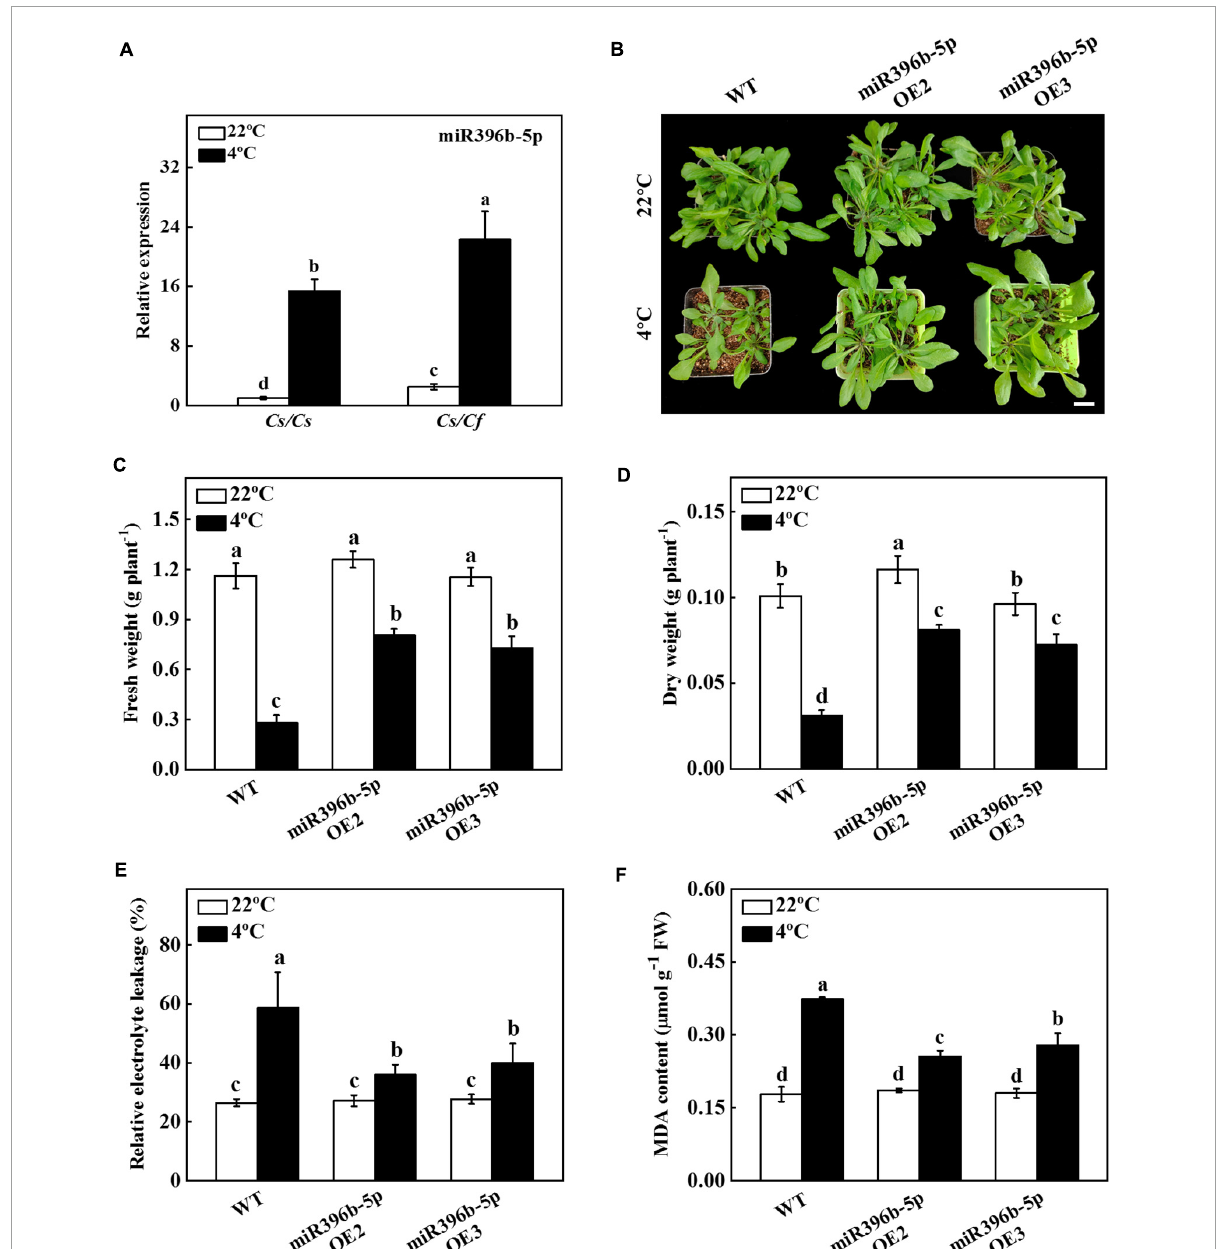
FIGURE2 Functional analysis of miR396b-5p in response to cold stress. (A) The expression of miR396b-5p under cold stress. Cucumber seedlings grafted onto cucumber ( Cs/Cs ) and figleaf gourd ( Cs/Cf ) were treated with cold stress at 4 ◦ C for 24 h, and the expression of miR396b-5p was detected by qPCR. (B) Overexpression of cucumber miR396b-5p in Arabidopsis improved cold stress tolerance. Bar: 1 cm. (C) Fresh weight. (D) Dry weight. (E) Relative electrolyte leakage (REL). (F) Malondialdehyde (MDA) content in leaves. Arabidopsis seedlings were treated with cold stress at 4 ◦ C for 7 d, and the phenotype, fresh weight, dry weight, REL, and MDA content were measured. The results represent the mean ± SD ( n = 3). Means with the same letter did not significantly differ at P < 0.05 according to Tukey’s test. FW, fresh